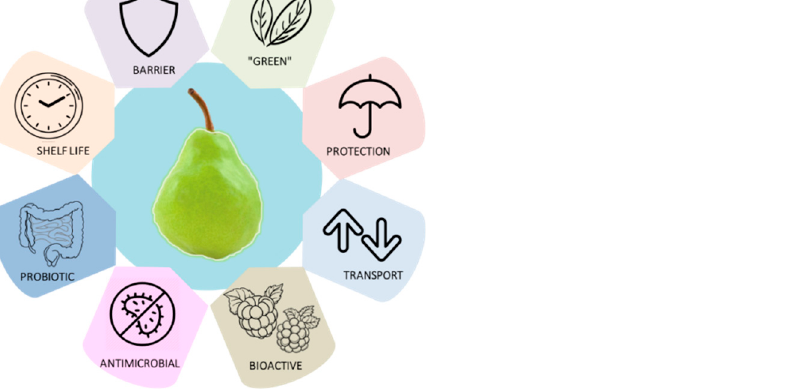
Figure 2. Scheme illustrating the main characteristics of edible films and coatings.